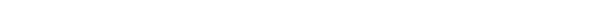
Fig. 3 Mitochondrial fi ssion is driven by Met kinase. a Huh7 cells were stimulated with HGF (100 ng/ml, 20 min) or not and then immuno fl uorescent stained for Met and Tom20. Percentages of cells with indicated mitochondrial morphologies were shown. Scale bars, 5 µm. Error bars represent means ± SEM ( n represents the number of cells analyzed, * p < 0.05; Student ’ s t test). b Quanti fi cation of median branch length of individual mitochondria ( n = 7 cells) and mean mitochondria number per cell ( n = 8 cells) according to ( a ). Error bars represent means ± SEM (* p < 0.05, ** p < 0.01; Student ’ s t test). c Immunoblot analysis of Drp1 and p-Met (Y1234-5) in mitochondrial and cytosolic fractions of Huh7 cells treated with HGF (100 ng/ml, 20 min). Mitochondria isolation markers, α -Tubulin (cytoplasmic) and Hsp60 (mitochondria) were used as controls. d Huh7 cells stimulated with HGF (100 ng/ml, 20 min) were immuno fl uorescent stained for Drp1 and mitochondria. Representative 3D SIM images of Drp1 assembly in mitochondria were shown. Images were captured in Z -stacks (frame, 10 µm × 10 µm; main calibration, 1 µm). Quanti fi cation of percentages of Drp1 puncta at mitochondria ( n = 5 fi elds) and Drp1 puncta at per µm 2 of mitochondria ( n = 31 fi elds). Error bars represent means ± SEM (** p < 0.01; Student ’ s t test). e Met − / − HeLa cells expressing WT EGFP- Met and mCherry – Mito were treated with HGF (100 ng/ml, 20 min). Representative time-lapse SIM live-cell imaging shows that Met contacts mitochondria at division sites before mitochondrial fi ssion events happen (indicated with white arrows). Scale bars, 1 µm. Two fi elds were taken. f Quanti fi cation of percentages of mitochondrial division events that are marked by Met in HeLa cells transfected with WT EGFP-Met and mCherry – Mito ( n = 46 events in 25 cells, p < 0.001, Fisher ’ s exact test). Quanti fi ed from SIM live-cell imaging described in ( e ). g Time-lapse SIM live-cell imaging shows Met contacts with mitochondria at the sites of mitochondrial division before fi ssion (indicated with white arrows) in Met − / − HeLa cells expressing WT EGFP-Met and mCherry – Mito with crizotinib (1 µM, 1 h) or ARQ-197 (5 µM, 1 h) treatments. Scale bars, 1 µm. Percentages of mitochondrial fi ssion (Mito- fi ssion) events marked by Met are quanti fi ed. Error bars represent means ± SEM (** p < 0.01; Student ’ s t test). Data are representative of seven independent experiments, 46 events per experiment. h Time-lapse N-SIM live-cell imaging of Met contacting mitochondria at the sites of mitochondrial division before fi ssion (indicated with white arrows) in Met − / − HeLa cells expressing WT, KD, kinase-truncated or kinase-only EGFP-Met and mCherry – Mito. Scale bars, 1 µm. Percentages of Mito- fi ssion events marked by Met are quanti fi ed. Error bars represent means ± SEM (** p < 0.01; Student ’ s t test). Data are representative of seven independent experiments, 62 events per experiment. i , j Huh7 cells were treated with HGF (100 ng/ml, 20 min) ( i ), crizotinib (1 µM, 1 h), ARQ-197 (5 µM, 1 h) or SU11274 (1 µM, 1 h) ( j ), and then subjected to Live Cell Imaging. Mito- fi ssion rates are quanti fi ed. Error bars represent means ± SEM ( n = 7 cells, ** p < 0.01; Student ’ s t cells (Supplementary Fig. S2c) and HT29 colon cancer cells (Supplementary Fig. S2d), which was analogously enhanced by HGF but diminished by crizotinib. However, in LO2 normal liver cells, the interaction between Met and Fis1 was weak and could not be